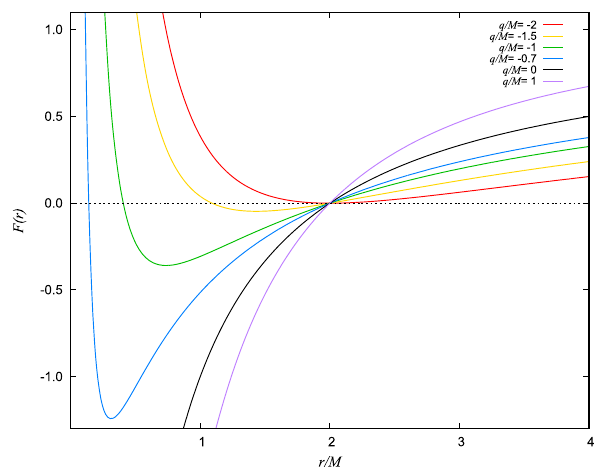
Fig. 1 F ( r ) as a function of r / M with different values of